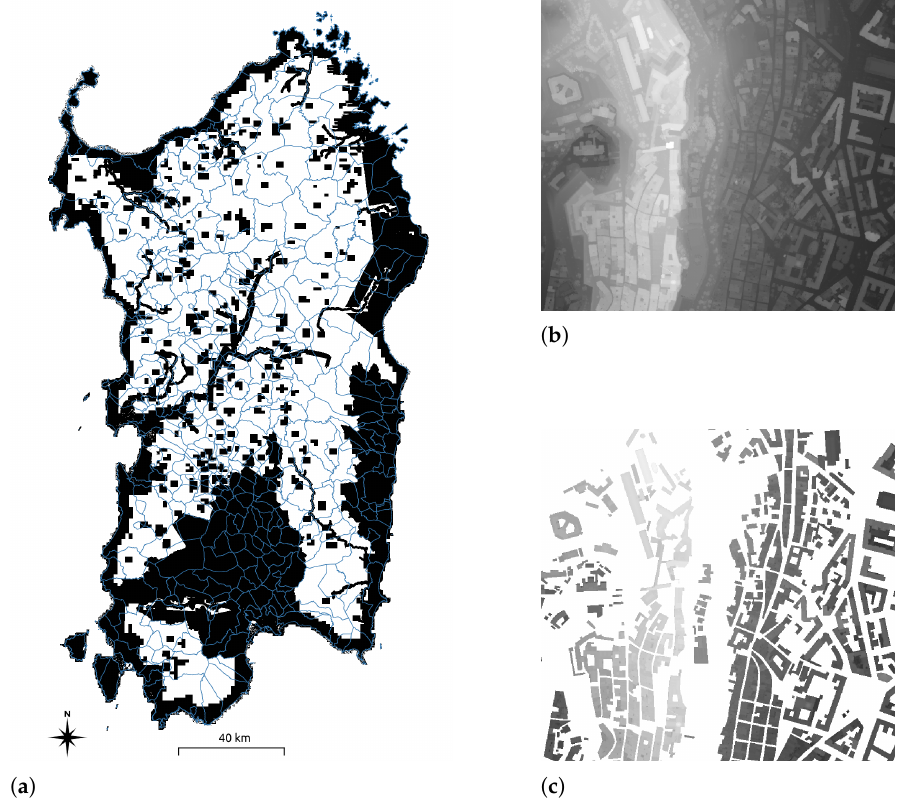
Figure 2. ( a ) Coverage of the 1 m resolution DSM (in black) over the territory of Sardinia and ( b , c ) a clipping of the DSM within the Municipality of